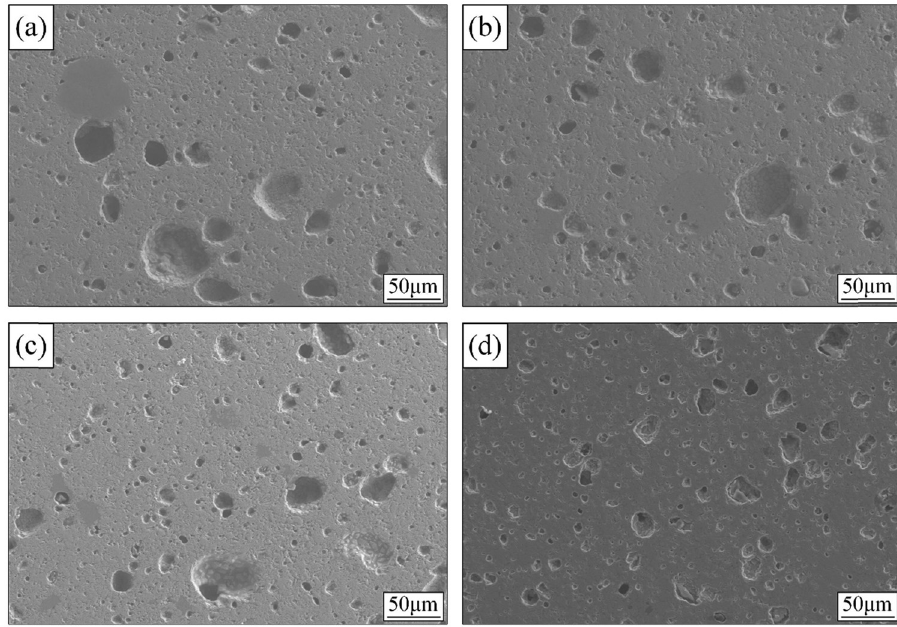
Figure 5: SEM images of fi red briquettes at di ff erent fi ring temperatures ( basicity = 0.83 ) ( a ) 1,230°C; ( b ) 1,250°C; ( c ) 1,280°C; ( d )